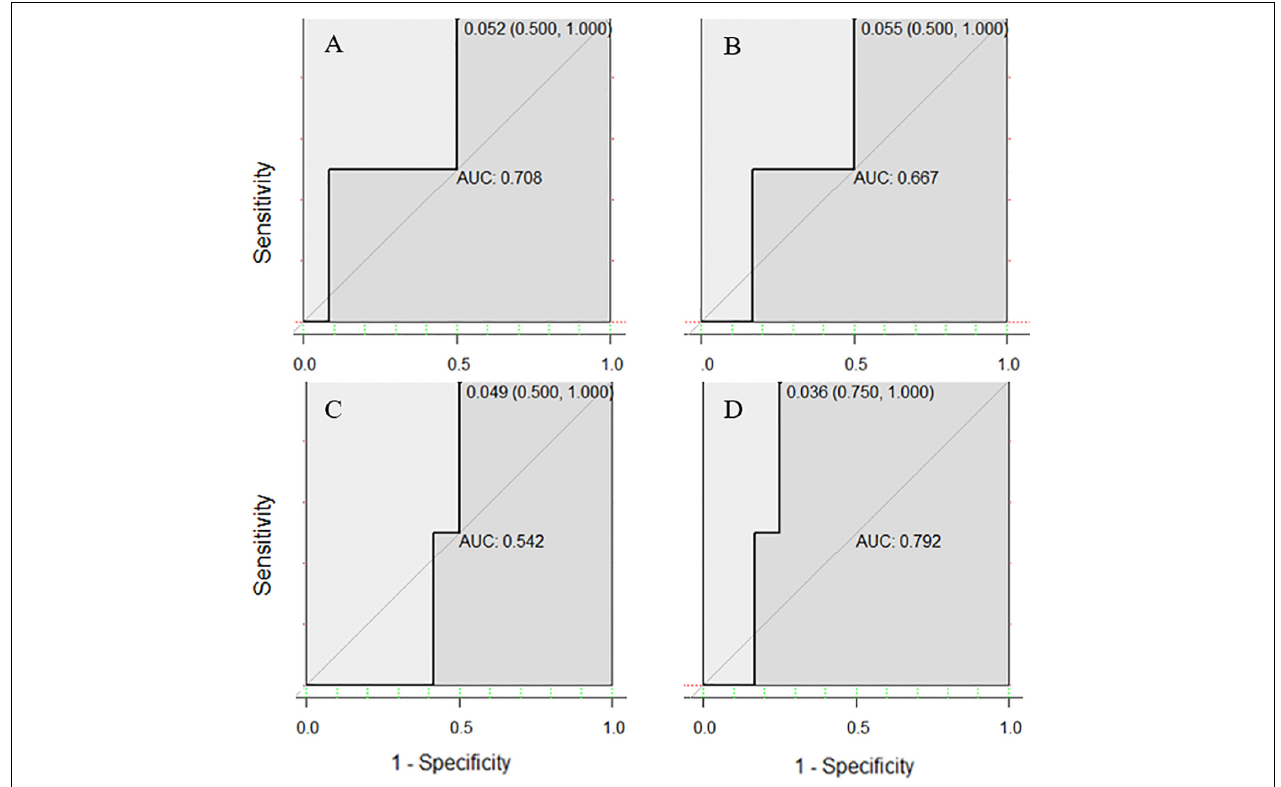
FIGURE 7 | Receiver operating characteristic curves for two-back-related frontal P3 amplitude (A) , P2 latency (B) , and DMS-related theta ERS (C) , and their combination based on electrode sites selected from the ANOVA test (D) using the SVM model.